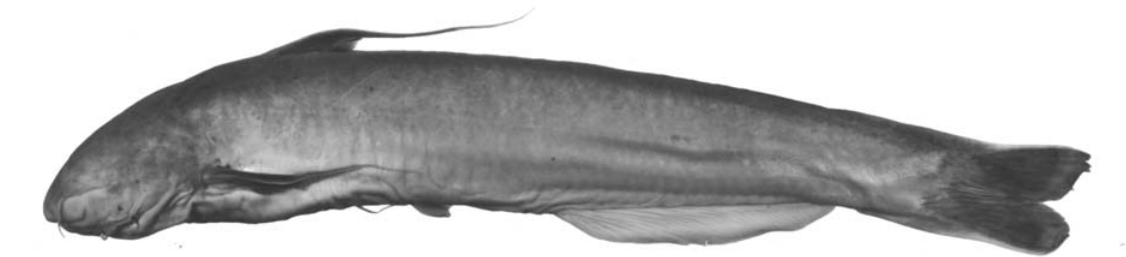
Fig. 16 . Cetopsis candiru , MCZ 56018, female, 131 mm SL; Brazil, Amazonas, rio Solimões approximately 0.5 km from mouth of paraná de Januaca, on south bank of river (3 o 25’S, 61 o 21’W).